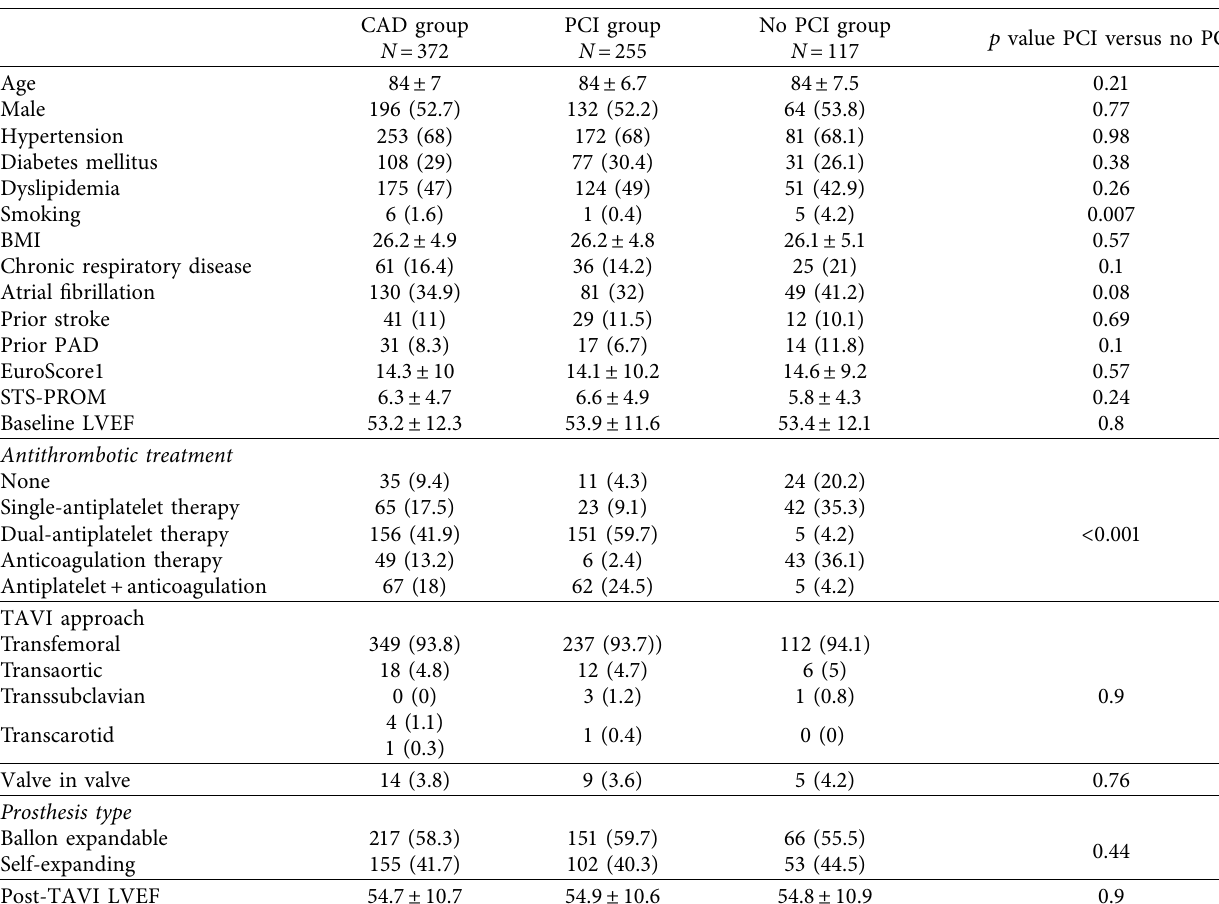
Table 4: Baseline characteristics of PCI subgroup in CAD-TAVI population.